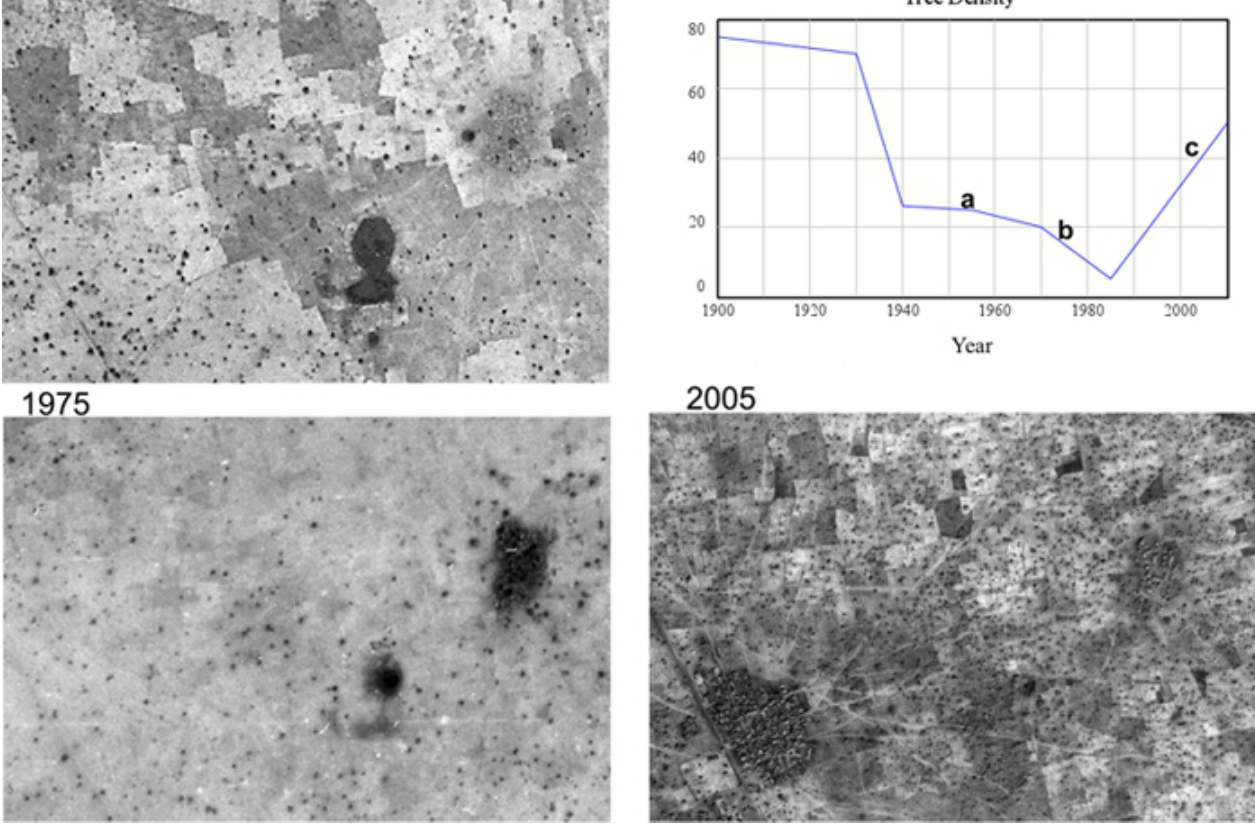
Fig. 4 . Tree cover trends estimated as changes in tree density (unit = percent of precolonial tree cover): landscape dynamics in southwest Zinder. Remote sensing imagery courtesy of Dr. G. Tappan (Tappan and Cushing 2004, 2008). Scale is 1:5000. The 1975 aerial photos (1:50 000) were zoomed in to the specific terroir shown. Note: the emergence of a large village and severe shrinking of a wet area east of it may suggest that the 2005 image is of a different area, but all three images cover the identical geographical